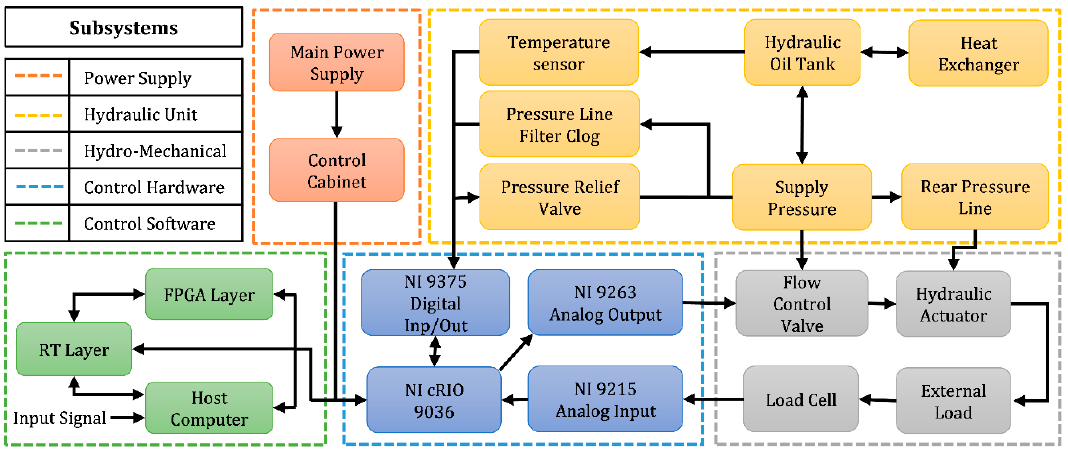
Figure 2. Schematic overview showing the flow of information to / from various (sub)systems of the electro-hydraulic actuator.